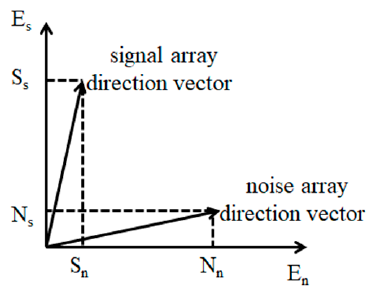
Figure 1. Projection analysis. Figure 1 . Projection analysis. Convert to SOCP and